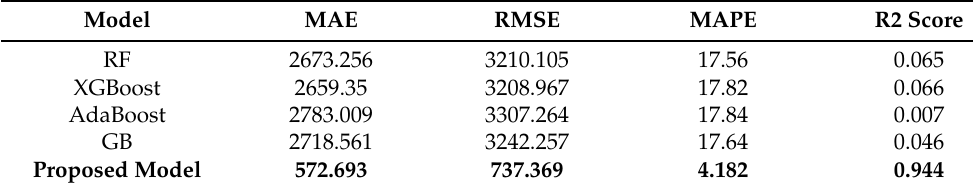
Table 3. Statistical analysis of proposed ensemble approach with conventional learning models for hourly electric consumption forecasting on building